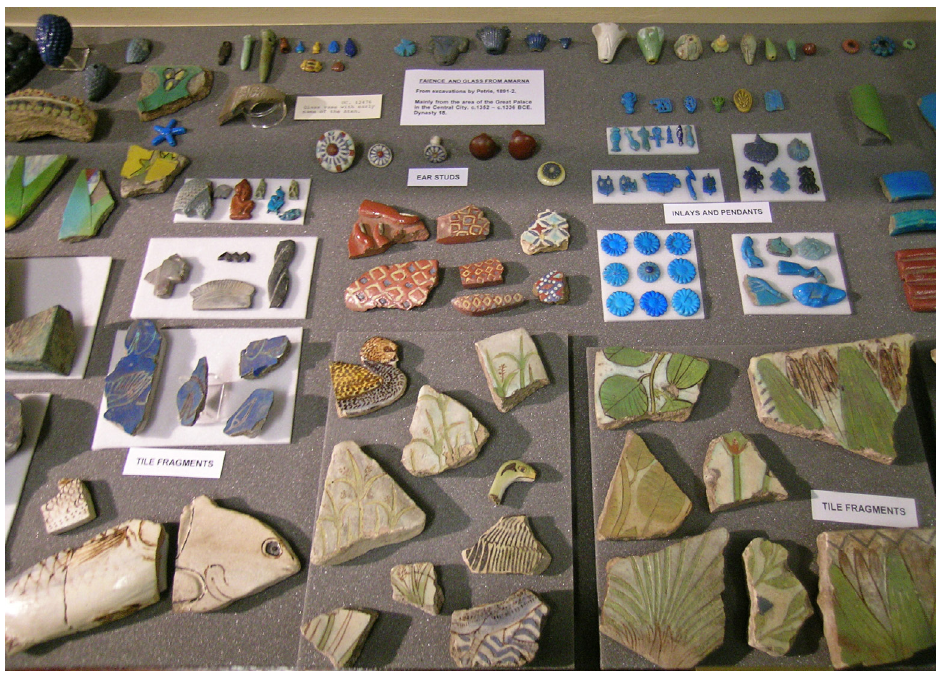
Fig. 4: A small part of the 1,000+ faience tiles, inlays and moulds from Amarna (Petrie Museum: display case